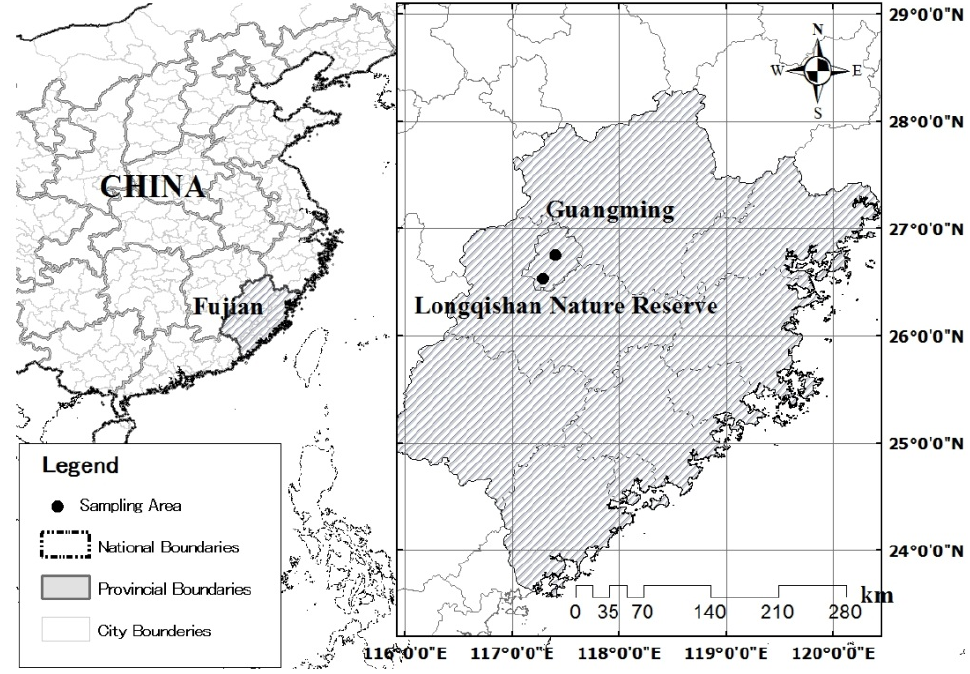
Figure 1. Location of study area and sampling sites.